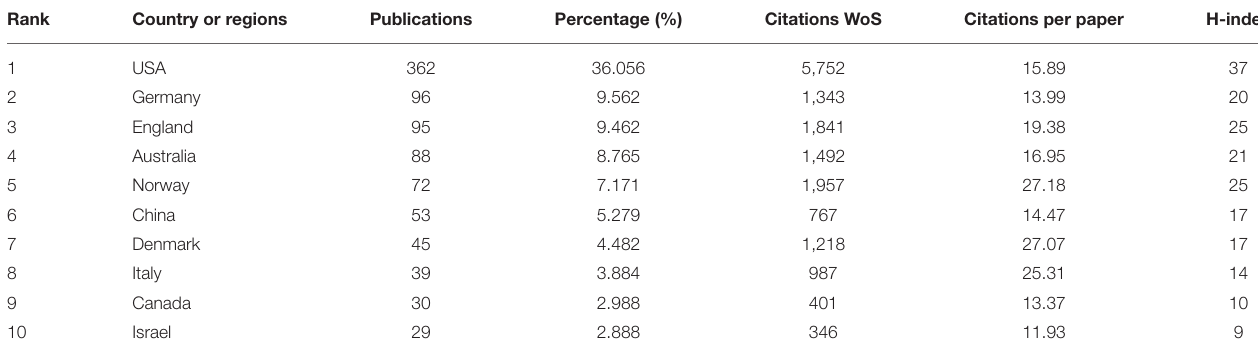
TABLE 1 | Top 10 countries or regions of origin of study in the music therapy research